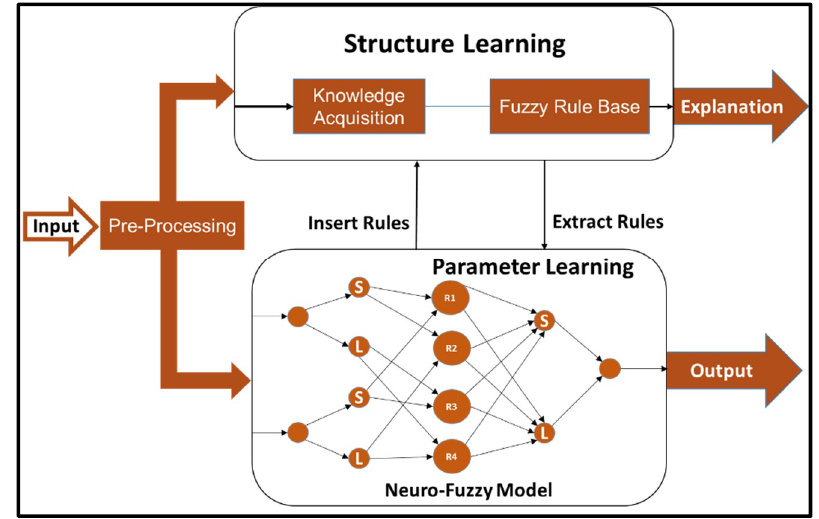
Figure 1. A general schematic diagram of the HyFIS.